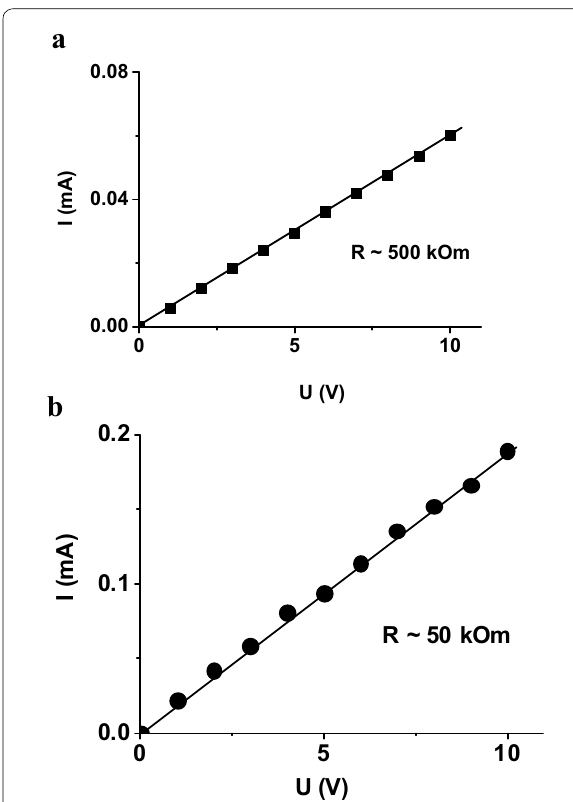
Fig. 2 Current-voltage characteristics for nc-SiC films of the series (MP-nc-SiC) ( a ) and (HP-nc-SiC) ( b ) on sapphire, measured in air at a temperature of 293 K Fig. 3 Current-voltage characteristics of the MP-nc-SiC ( a ) and